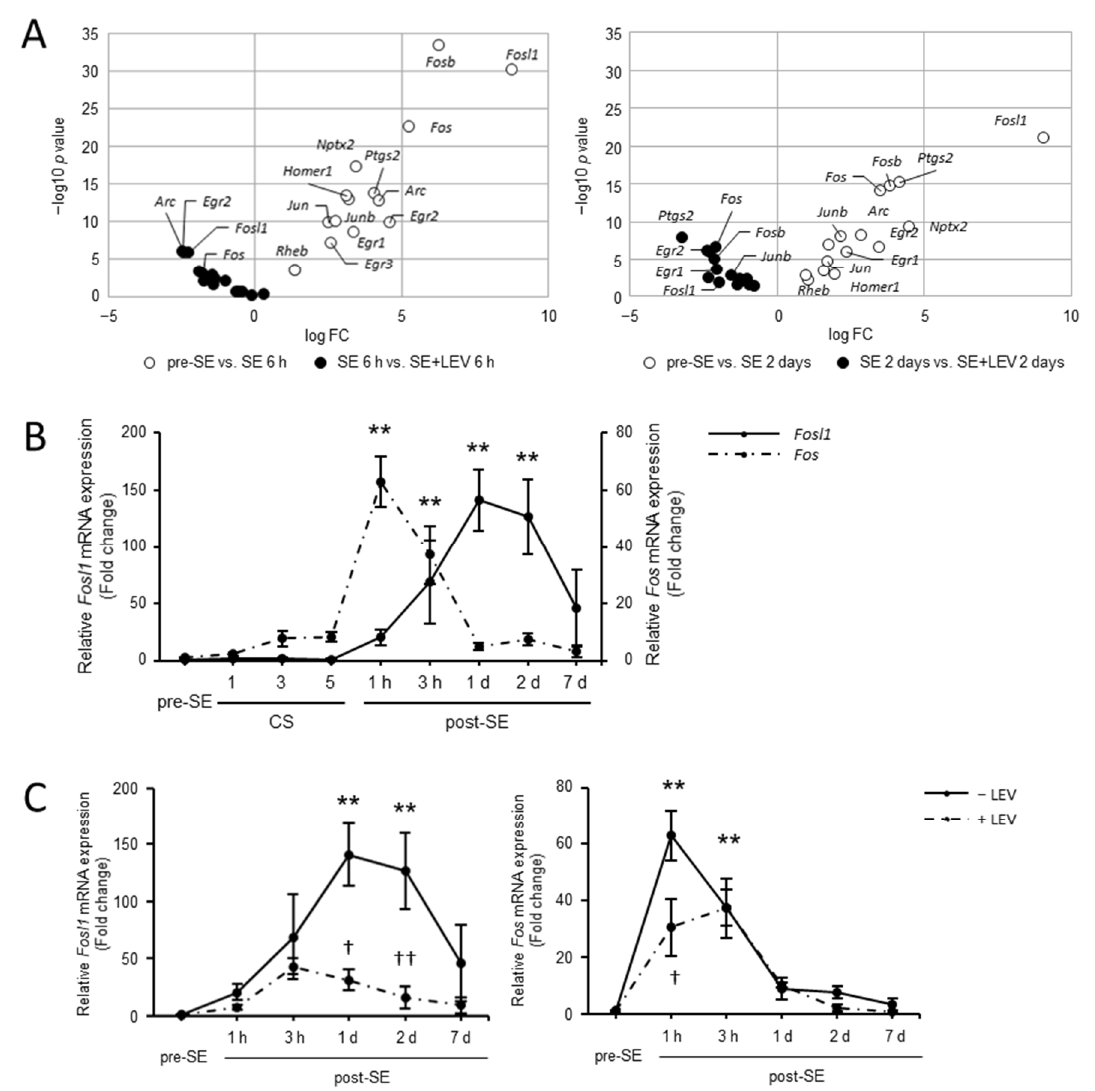
Figure 4. Alterations in gene expression levels of hippocampal neuronal IEGs after PILO-SE in mice treated with LEV or untreated. ( A ) Volcano plot showing major neuronal IEG expression differences between pre- and post-SE (open circles) or in mice treated with LEV or untreated (filled circles) at 6 h (left panel) and 2 days (right panel) after SE. The x -axis shows the fold change values (log2) between two experimental groups, and the y -axis shows the − log10 p value. ( B ) Time-course real-time PCR analysis of Fosl1 and Fos mRNA expression in the hippocampus after PILO-SE. Total RNA was extracted from the hippocampi of mice treated with PILO after the first, third and fifth consecutive generalized convulsive seizures (CSs); at 1 h, 3 h, 1 day, 2 days and 7 days post-SE; and pre-SE. Real-time PCR was performed using gene-specific primers as described in Table 1. ( C ) Real-time PCR analysis of Fosl1 and Fos mRNA expression in the hippocampus after SE in mice treated with LEV or untreated. Total RNA was extracted from the hippocampi of mice treated with PILO at 1 h, 3 h, 1 day, 2 days and 7 days post-SE and pre-SE in mice treated with LEV or untreated. The values were normalized relative to the β -actin ( Actb ) mRNA level and then divided by those of the control group (pre-SE) to calculate the relative mRNA levels. All data points represent the mean ± SEM of at least three independent experiments ( n = 3–9). Data were analyzed for significant differences by one-way ANOVA and Tukey’s post-hoc test. Results with p values < 0.05 were considered statistically significant. ** p < 0.01 vs. pre-SE mice, †† p < 0.01, † p < 0.05 vs. without post-SE mice.